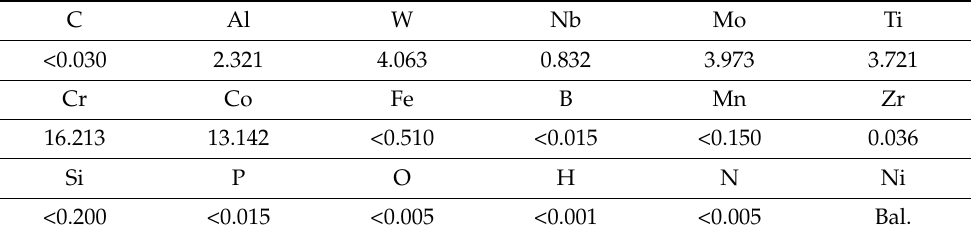
Table 1. Chemical composition of the nickel-based superalloy FGH4096 (wt.%). C Al W Nb Mo Ti <0.030 2.321 4.063 0.832 3.973 3.721 Cr Co Fe B Mn Zr 16.213 13.142 <0.510 <0.015 <0.150 0.036 Si P O H N Ni <0.200 <0.015 <0.005 <0.001 <0.005